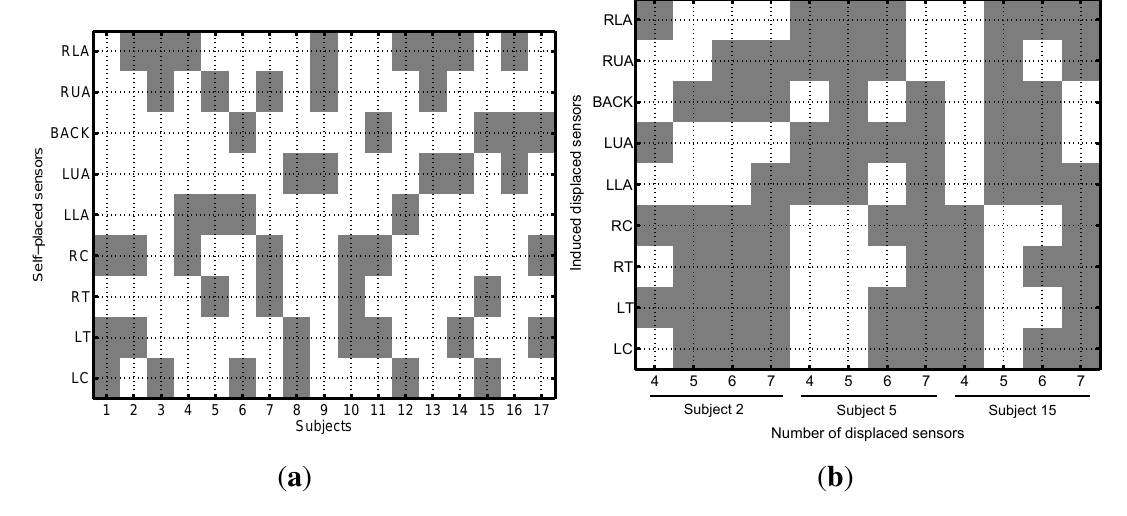
Figure 5. Shading spots identify the displaced sensors for the ( a ) self-placement and ( b ) induced-displacement deployments. Only Participants 2, 5 and 15 were considered in ( b